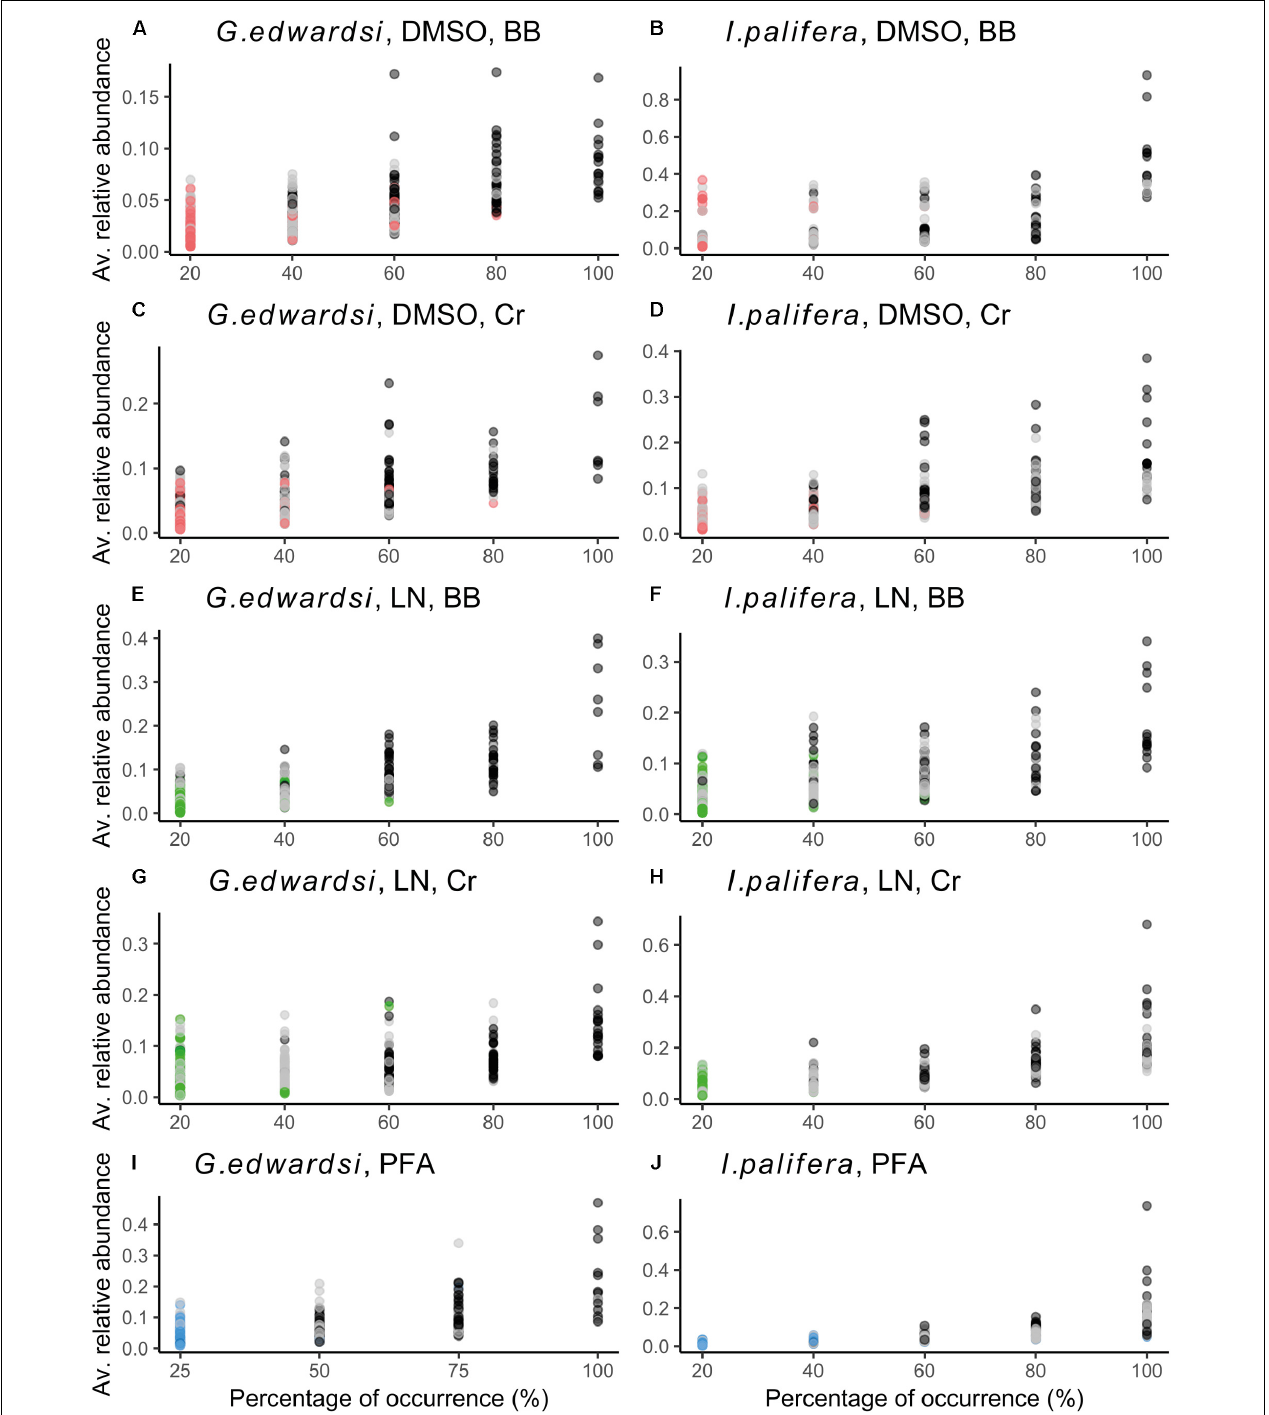
FIGURE 4 | Common/shared and specific phylotypes in bacterial assemblages sampled by different preservation and homogenization methods in G. edwardsi (A,C,E,G,I) and I. palifera (B,D,F,H,J) . Graphs of the average relative abundance vs. percentage of occurrence across methodologies revealed that specific bacterial phylotypes for each method are rare, low occurrence and low abundance (red, green, and blue dots across figures). Phylotypes with high occurrence and dominance, are common/shared OTUs across methodologies (gray and black dots). Red, green, and blue dots: OTUs present uniquely in the assemblage sampled by the referred combination method; gray dots: OTUs present in between 2 and 4 of the methods used; black dots: OTUs present in all the methods used. Left side: G. edwardsi , right side: I. palifera . Green: liquid nitrogen, red: DMSO, blue: PFA. LN, liquid nitrogen; BB, bead beating; Cr, crushing.